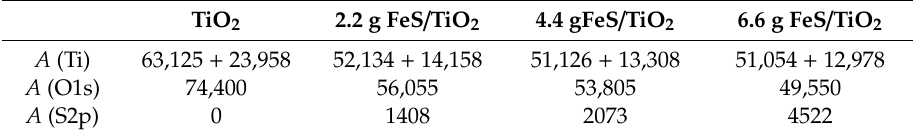
Table 1. The A (I × eV) of sample composition was obtained by XPS analysis and fitting peak.